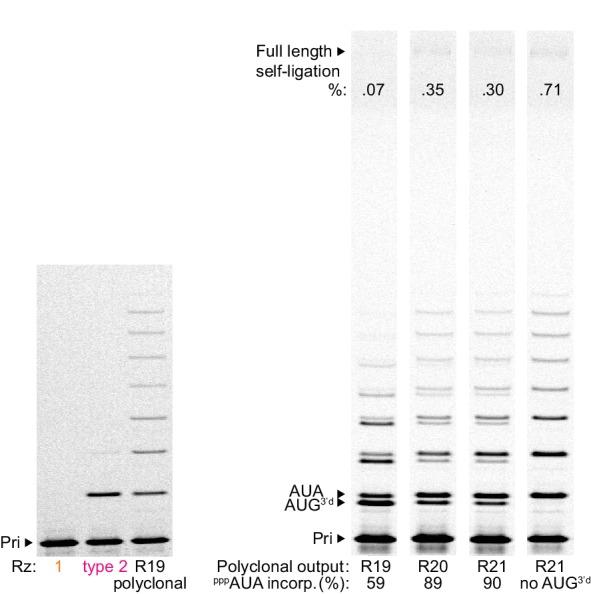
Clonal versus polyclonal activity.Type 1 and 2 RNAs, and the indicated polyclonal ribozyme pools late in the selection, were transcribed as selection constructs generated with Tri8AUAM (then annealed to primer A10). Their abilities to incorporate eight pppAUA triplets then self-ligate in this selection construct context were compared (left, 0.1 μM each RNA, 2 μM pppAUA, in −7˚C ice for 5 days; right, 0.2 μM each RNA, 2 μM pppAUA and pppAUG3’d, in −7˚C ice for 9 days). Left: Despite being the most active type (Figure 2b), type two activity fell far short of the round 19 pool polyclonal activity. Right: The incorporation of wobble pairing 3’-deoxy ‘terminator’ triplet pppAUG3’d (see results section on fidelity, yielding a faster-migrating band than incorporation of the cognate pppAUA triplet) was decreased sharply after round 19, as calculated by densitometry and averaging amongst the ligation junctions in each lane, indicative of enrichment of higher fidelity triplet polymerases in the selection pool.